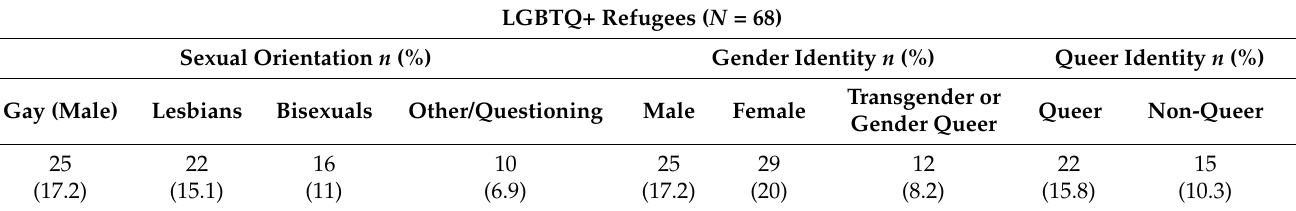
Table 2. Participant